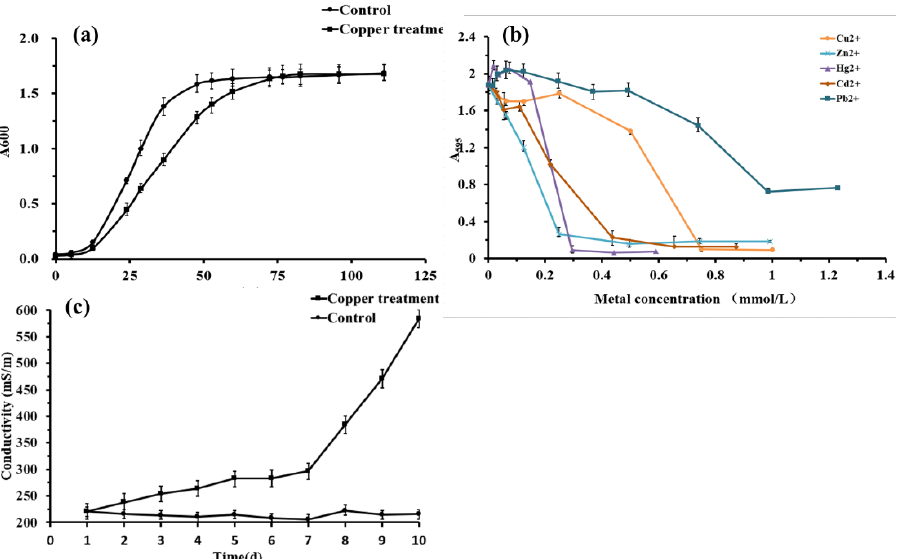
Figure 1. ( a ) Growth curves of the Planococcus sp. O5 in the absence and presence of 0.5 mmol/L Cu 2+ . ( b ) Heavy metal tolerance of Planococcus sp. O5 of Cu 2+ , Zn 2+ , Pb 2+ , Cd 2+ , and Hg 2+ , separately. ( c ) Effect of 0.5 mmol/L Cu 2+ on the conductivity of Planococcus sp. O5.